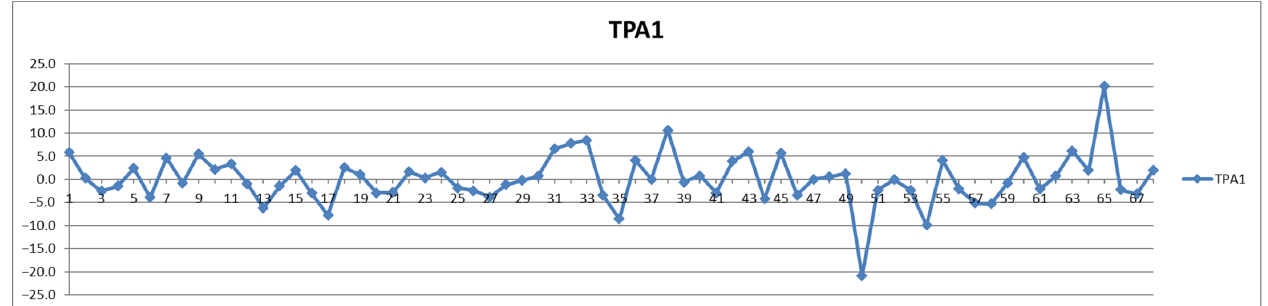
Figure 16. The food intake effect on total apolipoprotein A1 (TPA1) as difference between postprandial and fasting concentrations as percentage relative to fasting concentration.